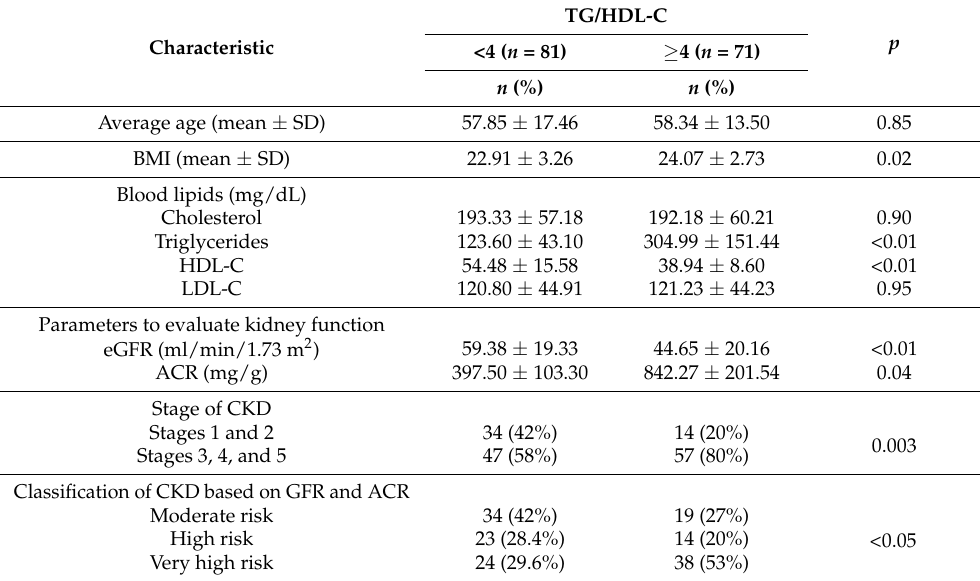
Table 3. Characteristics of patients with TG/HDL-C < 4 and ≥ 4.